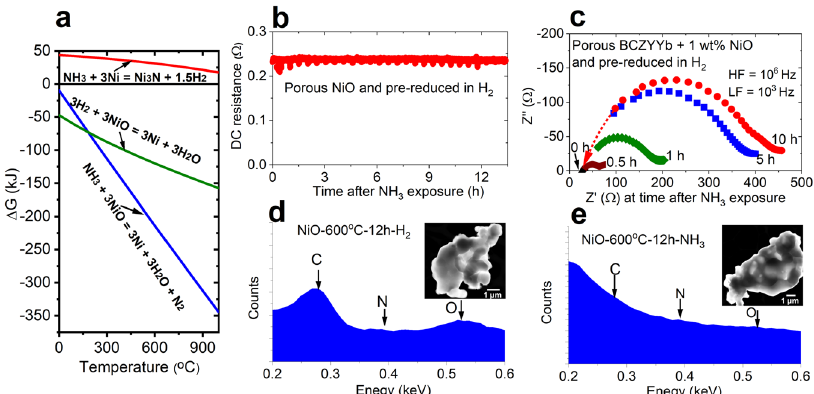
Fig. 5 Thermodynamic properties, electrochemical measurements and micro-characterization of degradation mechanism in NH 3 -fed PCFC. a Thermodynamic calculations for NiO reduction by H 2 and NH 3 , and Ni 3 N formation via NH 3 gas and metallic Ni. The fi gure shows that NH 3 is a stronger reducing agent than H 2 at temperatures exceeding 275 °C, and that Ni 3 N formation is thermodynamically unfavorable under typical PCFC operation temperatures. b DC resistance measurement of porous nickel pellet upon non-cracked NH 3 exposure at 600°C; steady performance is observed. c EIS measurement of a porous BCZYYb (with 1 wt% NiO) pellet during exposure to non-cracked NH 3 at 600 °C; polarization resistance increases by orders of magnitude over 10 h. d , e TEM-EDS analysis of nano-sized NiO after H 2 and non-cracked NH 3 exposure respectively. The comparison does not show the formation of Ni 3 N.